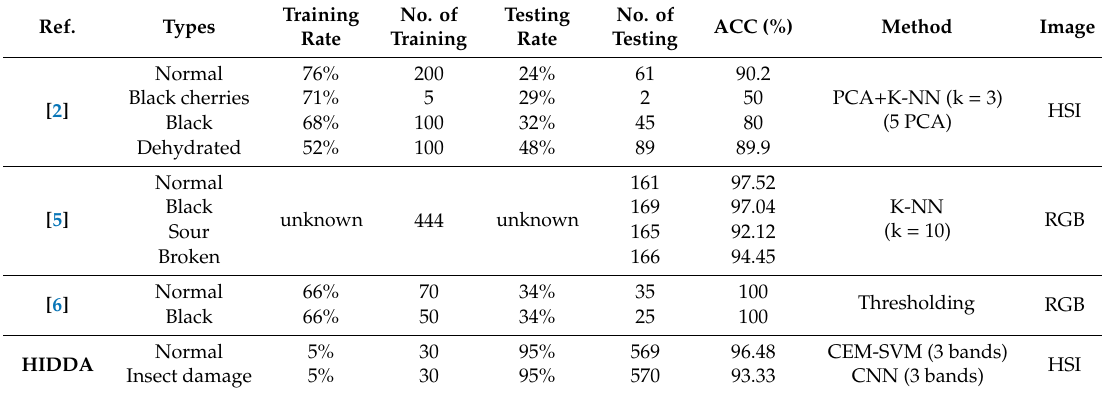
Table 7. The detailed comparison of prior